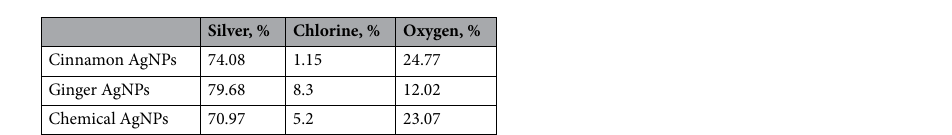
Table 1. EDX elemental analysis of cinnamon, ginger, and chemical AgNPs.